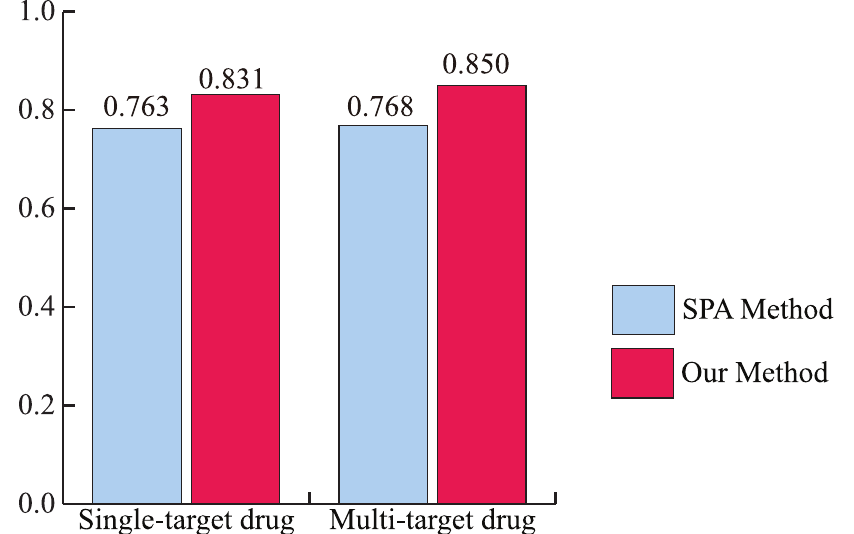
Fig 4. The AUC of our method and the SPA method for single-target drug and multi-target drug categories. The AUC of our method outperforms that of the SPA method in both single-target drug and multi- target drug